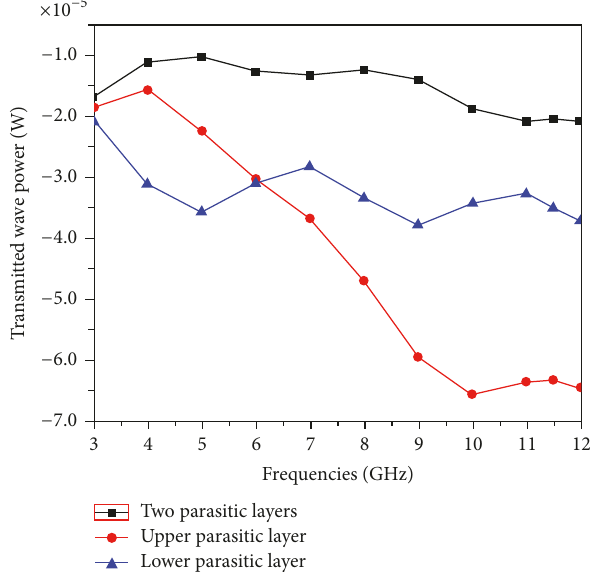
Figure 8: Total transmitted wave power flow for parasitic layers alone and